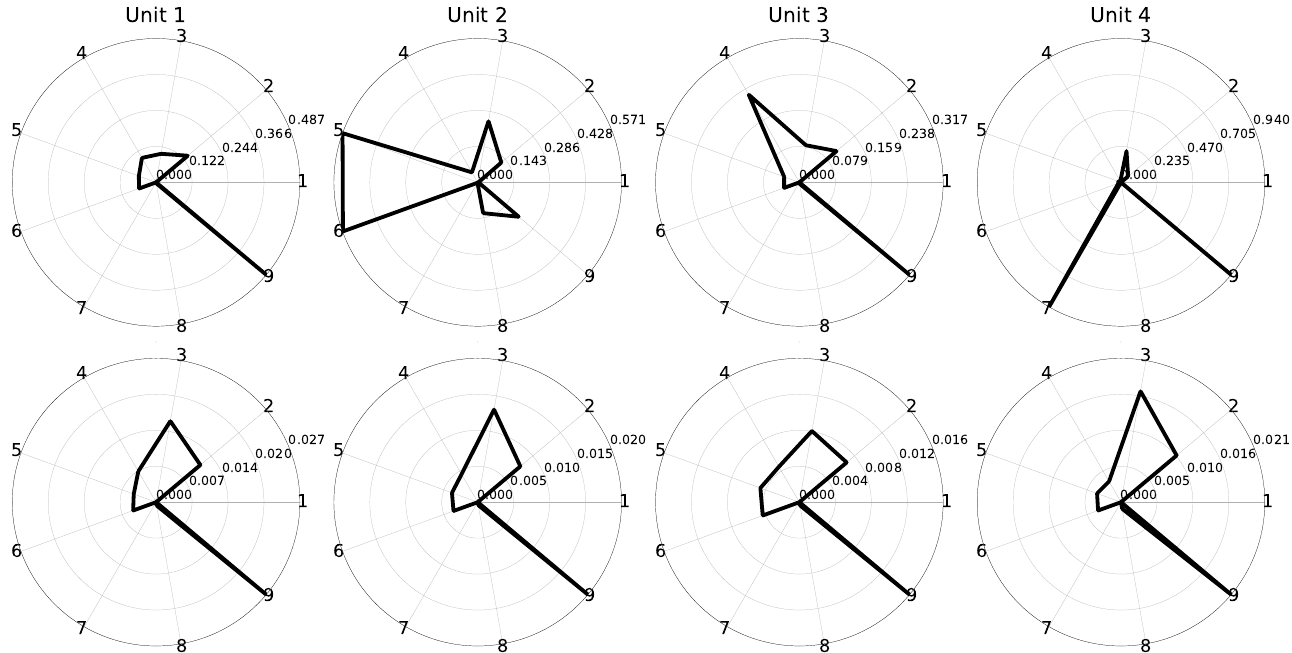
Figure 14. FCAE loss signatures per cooling unit for the true positive cases ( top ) and the false negatives ( bottom ). Figure 15 shows the plots for the cases where healthy flights are correctly classified (true negatives) or wrongly classified as faulty (false positives). For the true negatives, sensor 9 signals are the ones being reconstructed the worst, although its loss value is still relatively low enough. For the false positives, the situation is more complex as several sensors contribute to the misclassification. Furthermore, each unit has a different false positive signature, although the ones in unit 1 and 3 are close. Sensor 9 is in all cases the major contributor to false